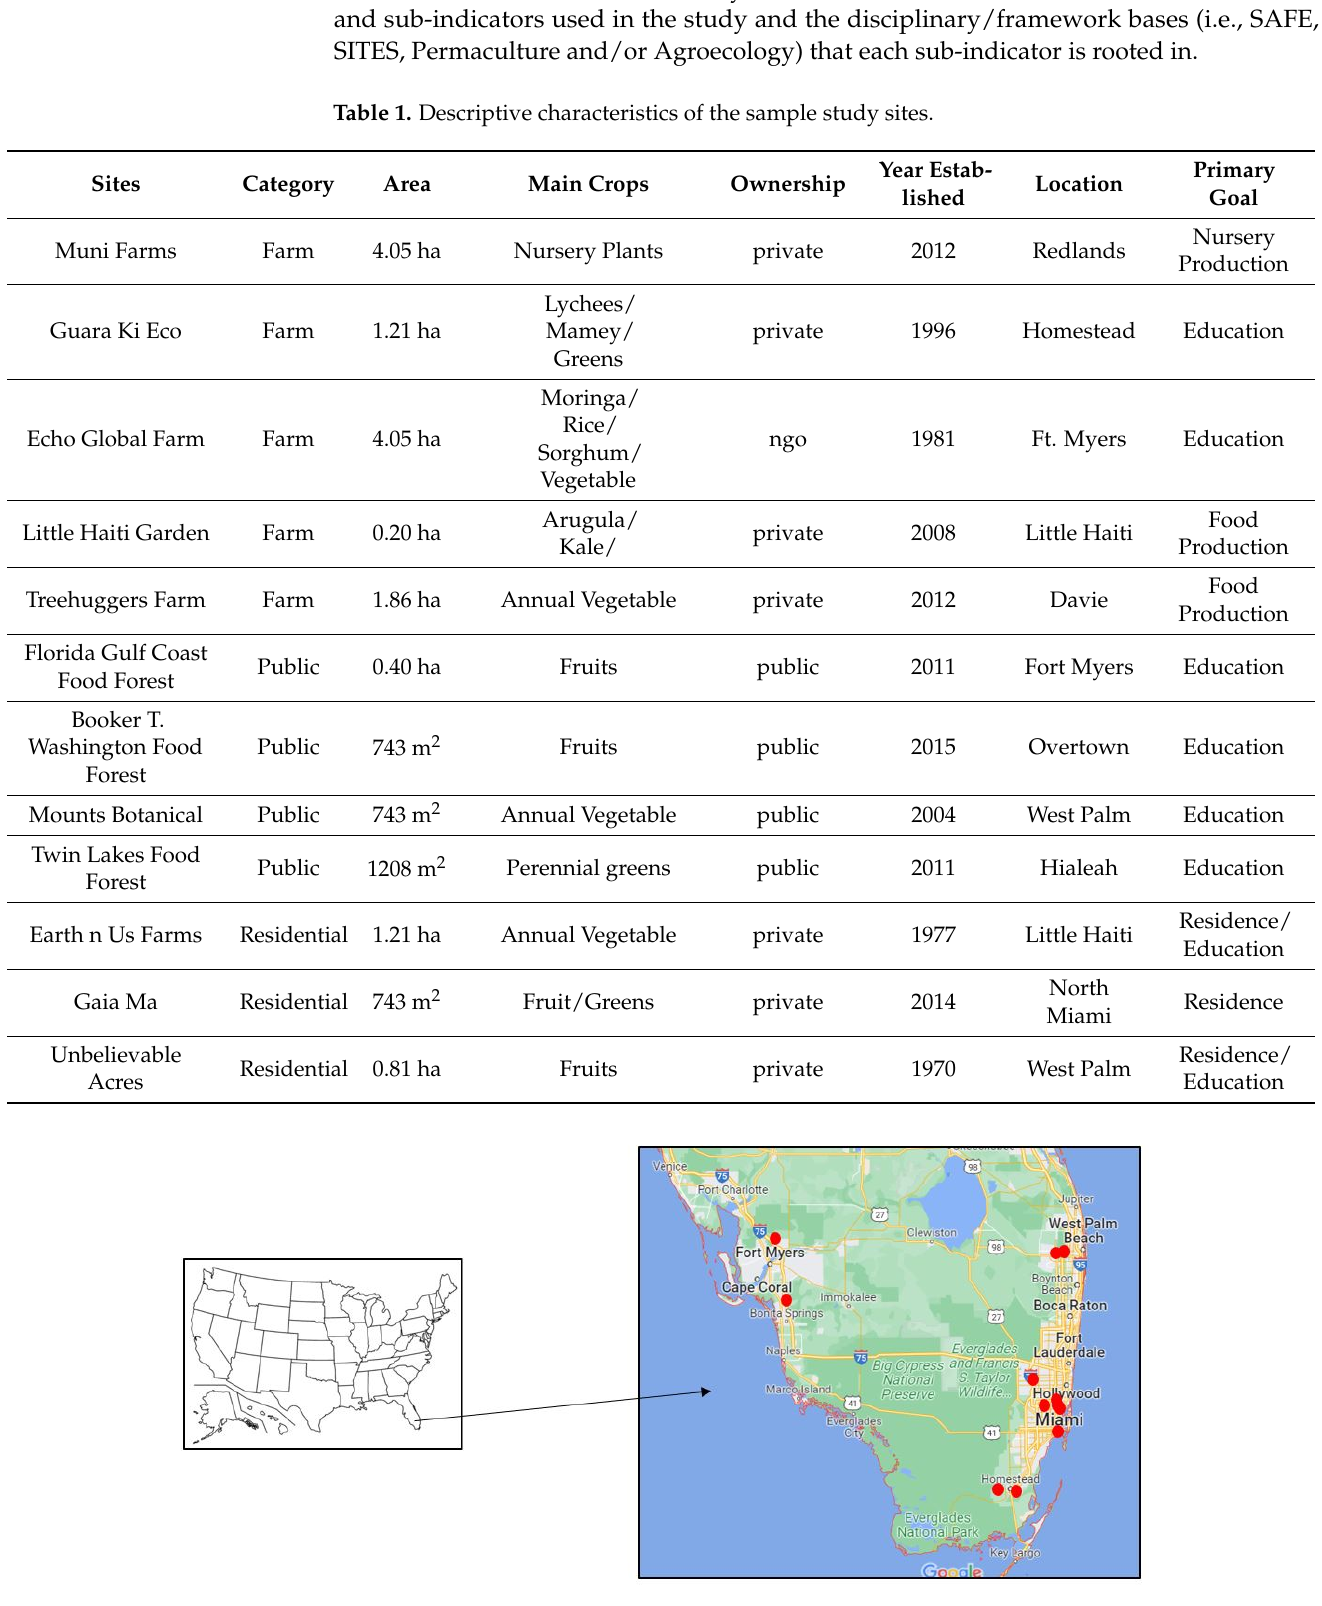
Figure 1. Map of sample farm sites in South Florida (created by authors using the study area map from Google